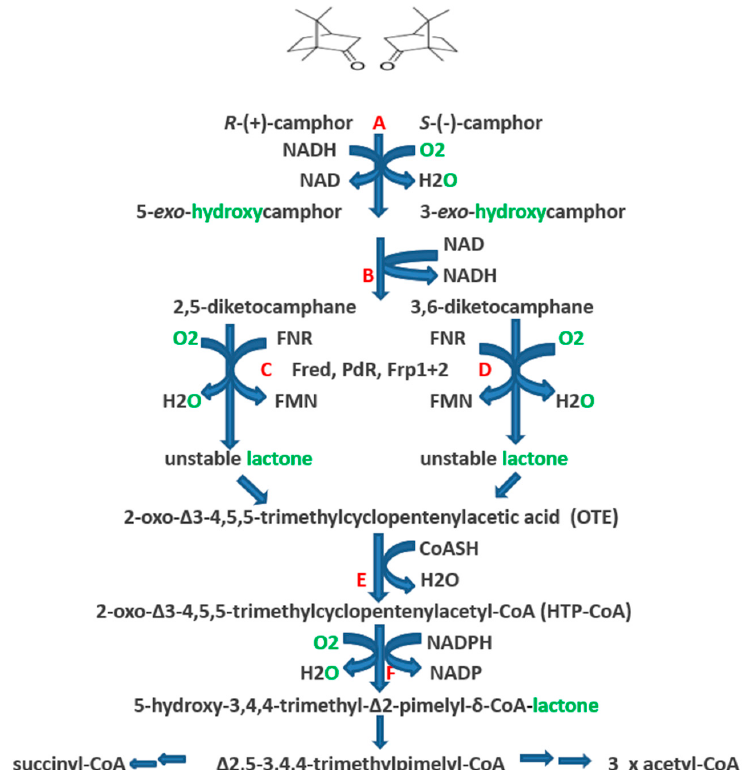
Figure 1. Pathway of (+)- and ( − )-camphor degradation in P. putida NCIMB 10007. A = cytochrome P450 monooxygenase ( camCAB ): B = exo -hydroxycamphor dehydrogenase ( camD ): C = 2,5-diketocamphane 1,2-monooxygenase ( camE 25-1 + camE 25-2 ): D = 3,6-diketocamphane 1,6-monooxygenase ( camE 36 ): E = 2-oxo- ∆ 3 -4,5,5-trimethylcyclopentenylacetyl-CoA synthetase ( camF1 + F2 ): F = 2-oxo- ∆ 3 -4,5,5-trimethylcyclopentenylacetyl-CoA monooxygenase ( camG ): Fred = 36 kDa chromosome-coded flavin reductase: PdR = putidaredoxin reductase subunit of cytochrome P45O monooxygenase ( camA ): Frp 1 + 2 = chromosome-coded ferric reductases: diatomic oxygen molecules participating in the four monooxygenase-catalysed steps is shown in green, as in each case are the fates of each component oxygen atom.